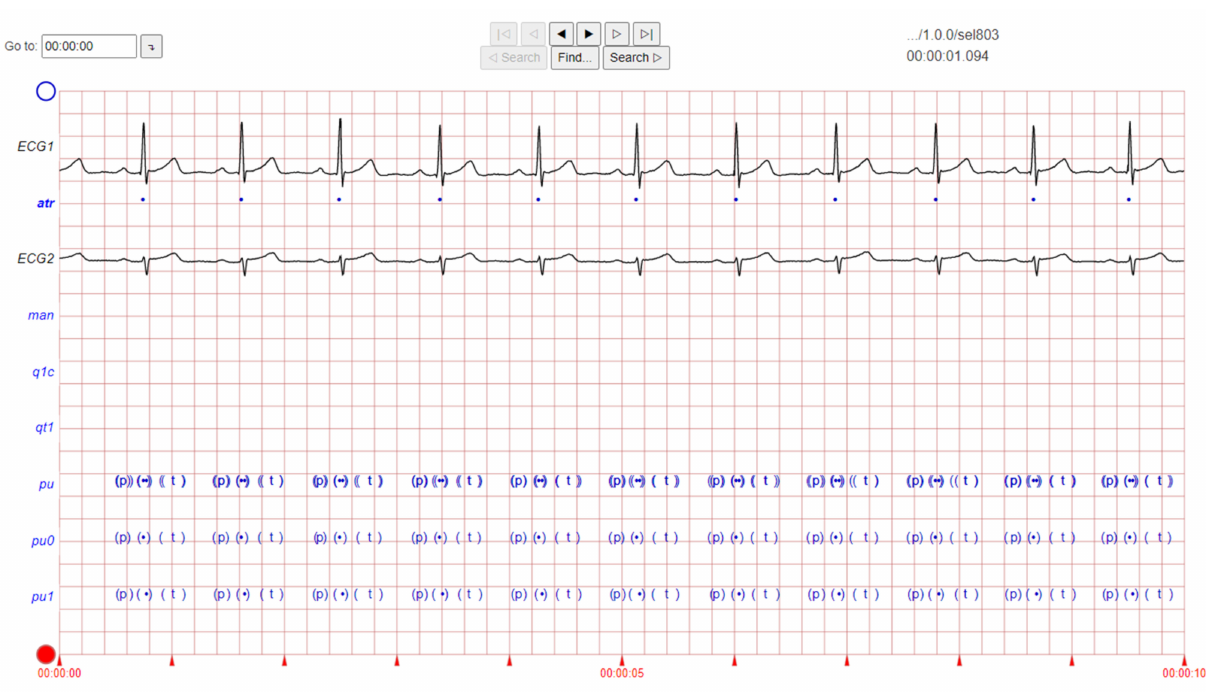
Figure 4. ECG image data for ‘supraventricular arrhythmia’